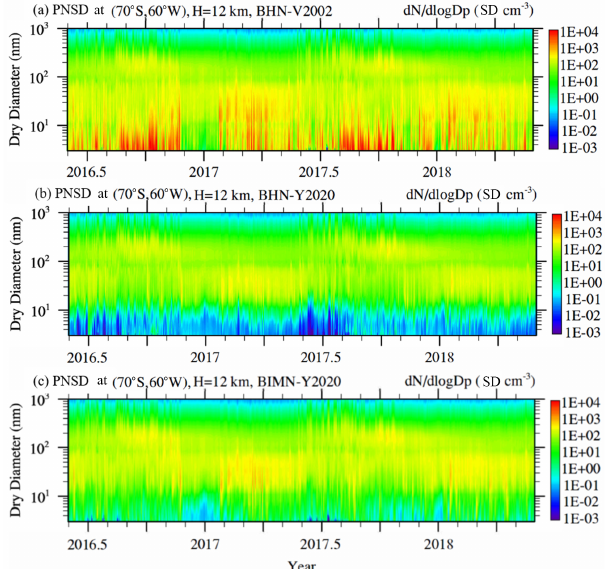
Figure 5. Model-simulated evolution of PNSDs at a site in the SH (70 ◦ S, 60 ◦ W) at an altitude of 12km based on three nucleation schemes (BHN_2002, BHN_Y2020, and BIMN_Y2020).